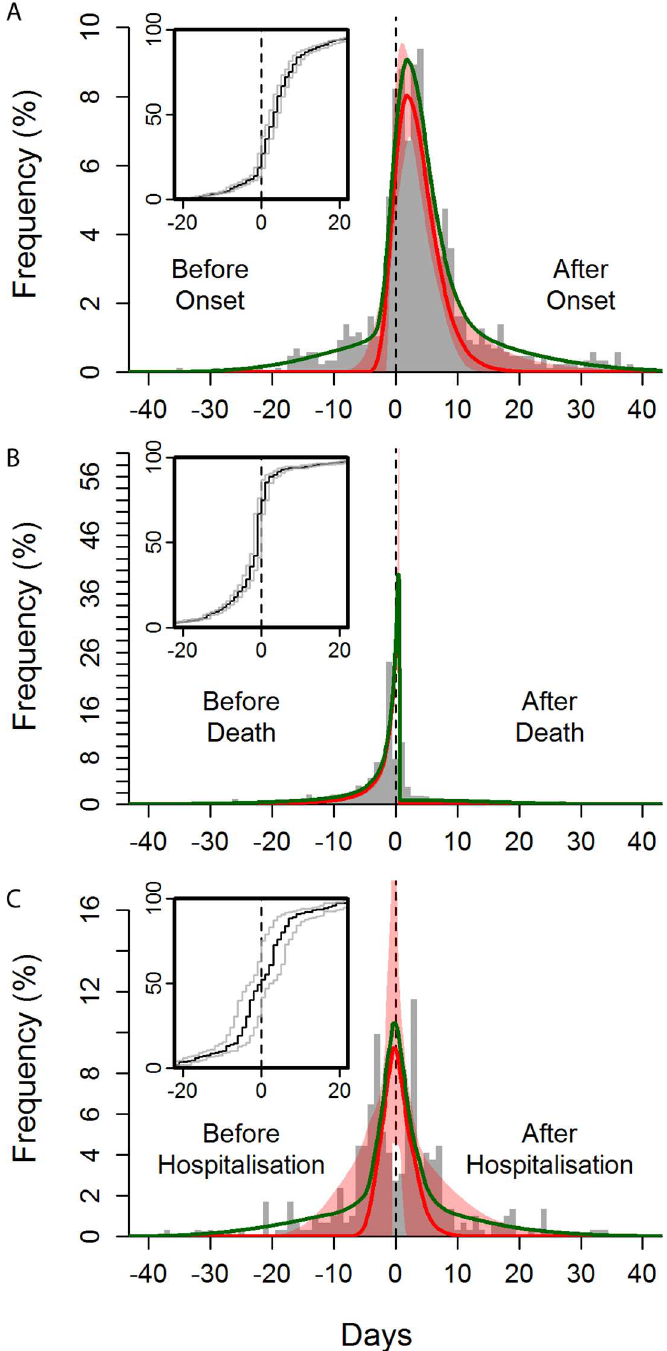
Fig 3. Observed and fitted distribution of reported time to non-funeral exposure from symptom onset, hospitalisation, and death of the contact. Time from symptom onset (A), death (B), and hospitalisation (C) of the contact to time of exposure. The green curves show the overall best fits, and the red curves show the best fits for the “signal” distribution (all obtainedby maximum likelihood).The red-shadedareas indicatethe 95% confidenceintervals of the fitted “signal”distribution.The histogramshows a randomset of exposure midpoints (in some instances, only a start or an end date of exposure is recorded; in those instances, the missing date is numerically imputed). Note that the fitting procedure is not performed on the midpointsbut fully incorporates the exposurewindow(see section 1.8 in S1 Text). The inset panels are the observedcumulative distribution functions for the midpoint(black line) and start and end (grey lines) of the